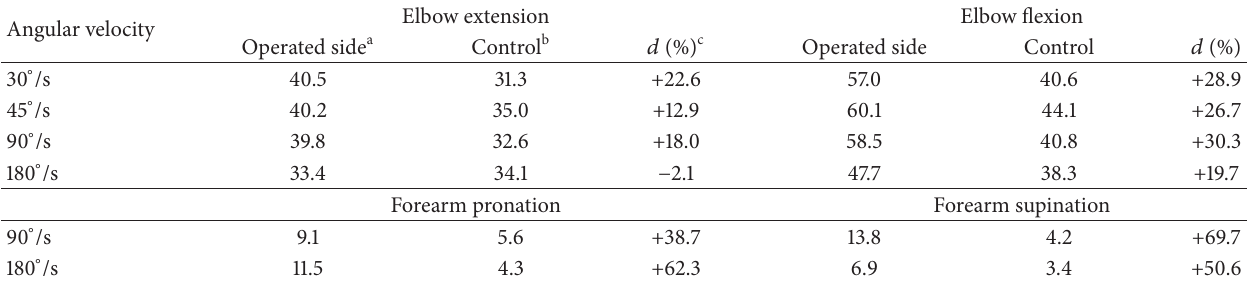
Table 1: Peak isokinetic strength (Nm) testing in elbow extension-flexion and forearm pronation-supination.